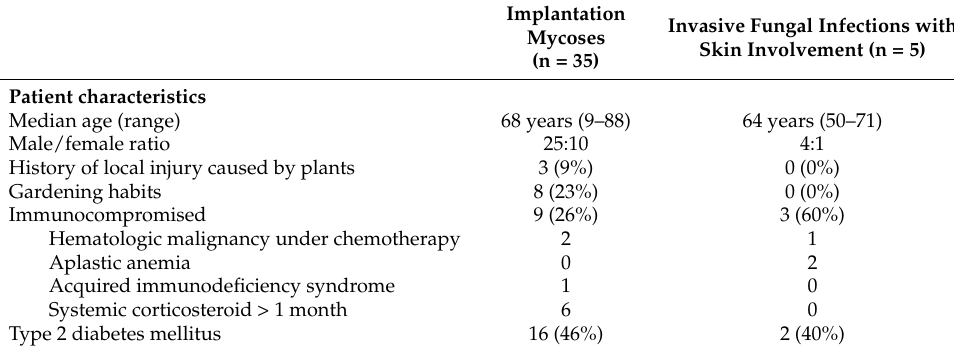
Table 1. The demographics and clinical characteristics in implantation mycoses and invasive fungal infections with skin